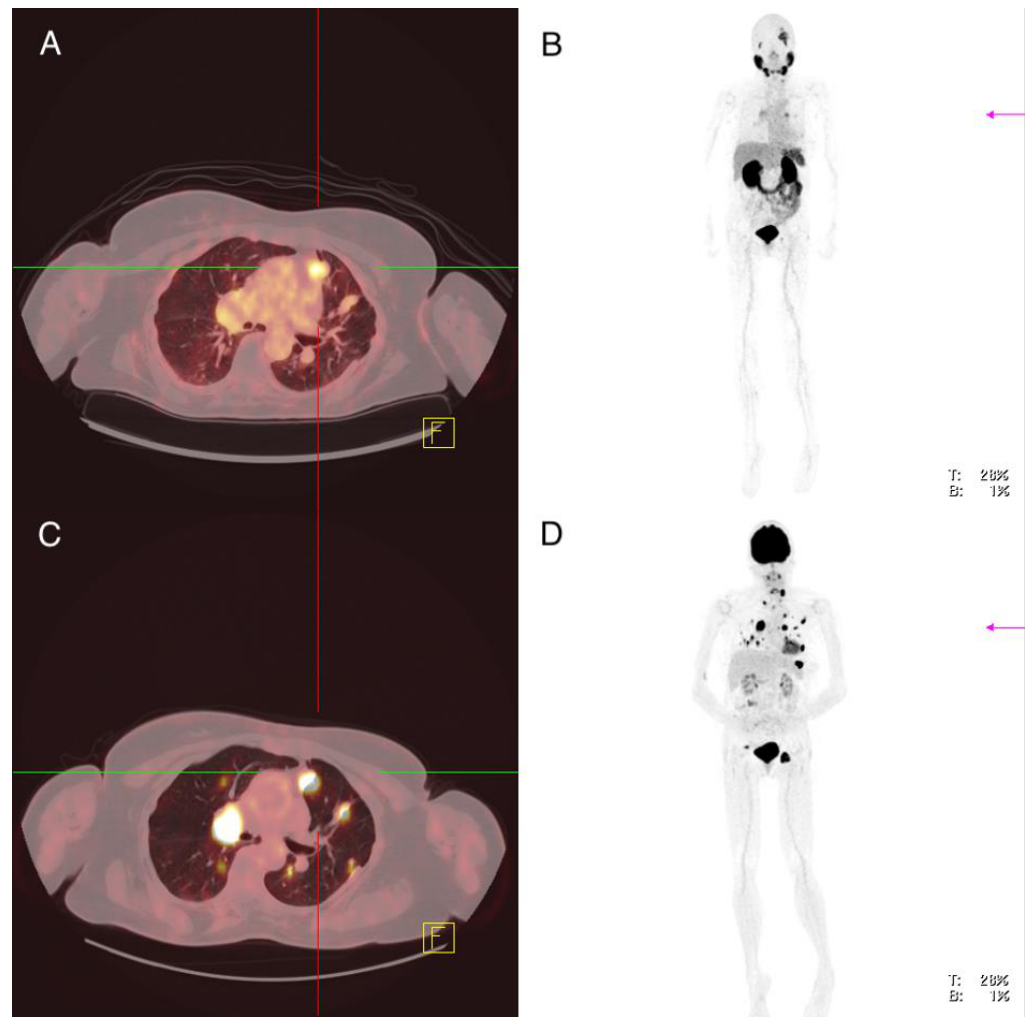
Figure 4. Patient 7: 68 Ga-PSMA-PET/CT ( A , B ), 18 FDG-PET/CT ( C , D ). Inhomogeneous PSMA expression of mediastinal lymph node metastases in the absence of PSMA expression of pulmonary lesions with increased glucose uptake.